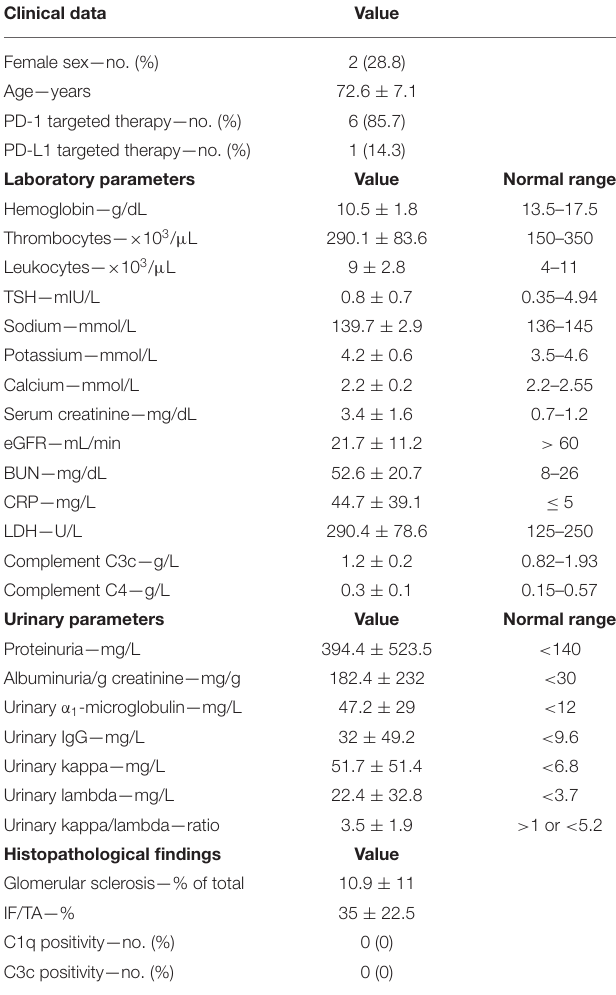
TABLE 1 | Clinical, laboratory and histopathological parameters of the total